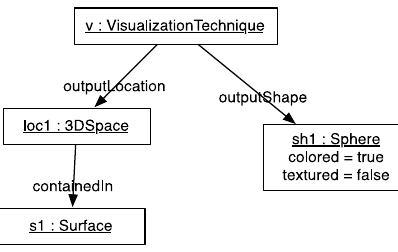
Figure 5. Description of the output rendering of an air quality visualization technique